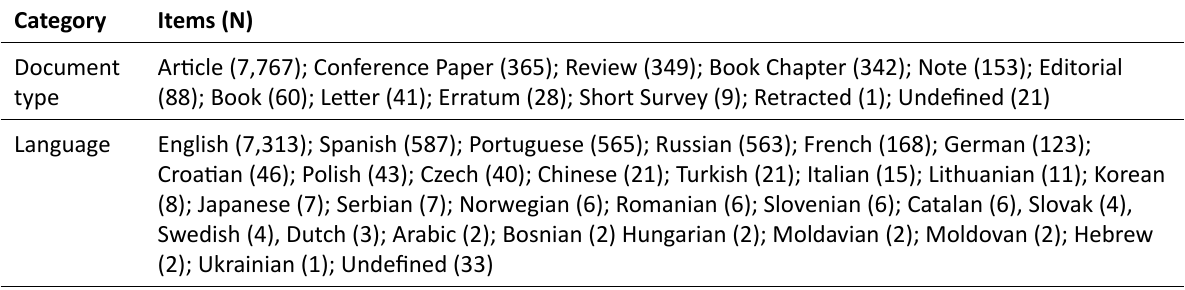
Table 1. Parameters of the research